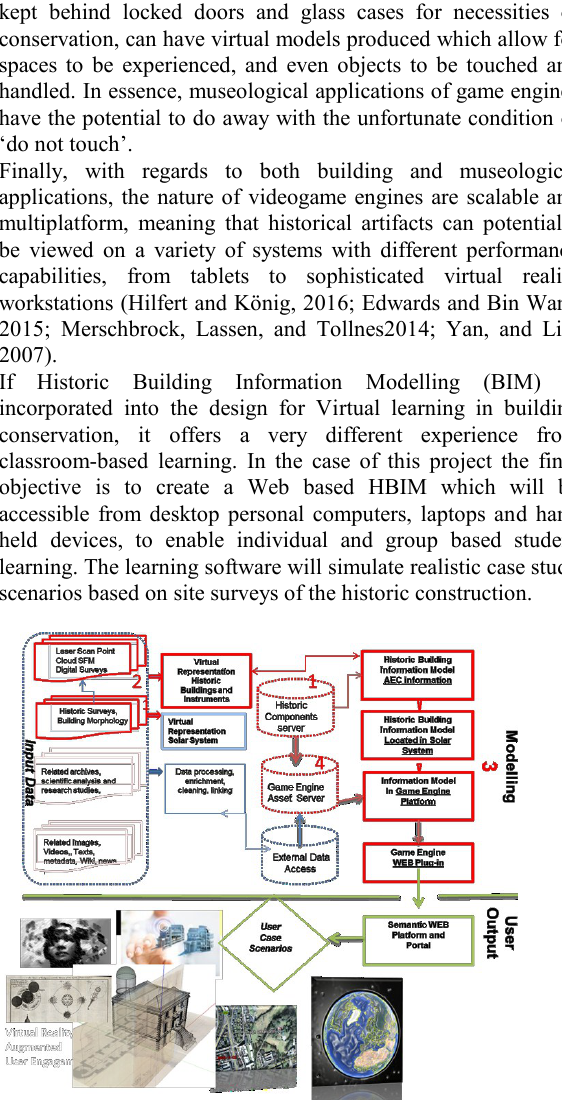
Figure 14: Systems Architecture for Virtual Reality Immersive Model of Armagh